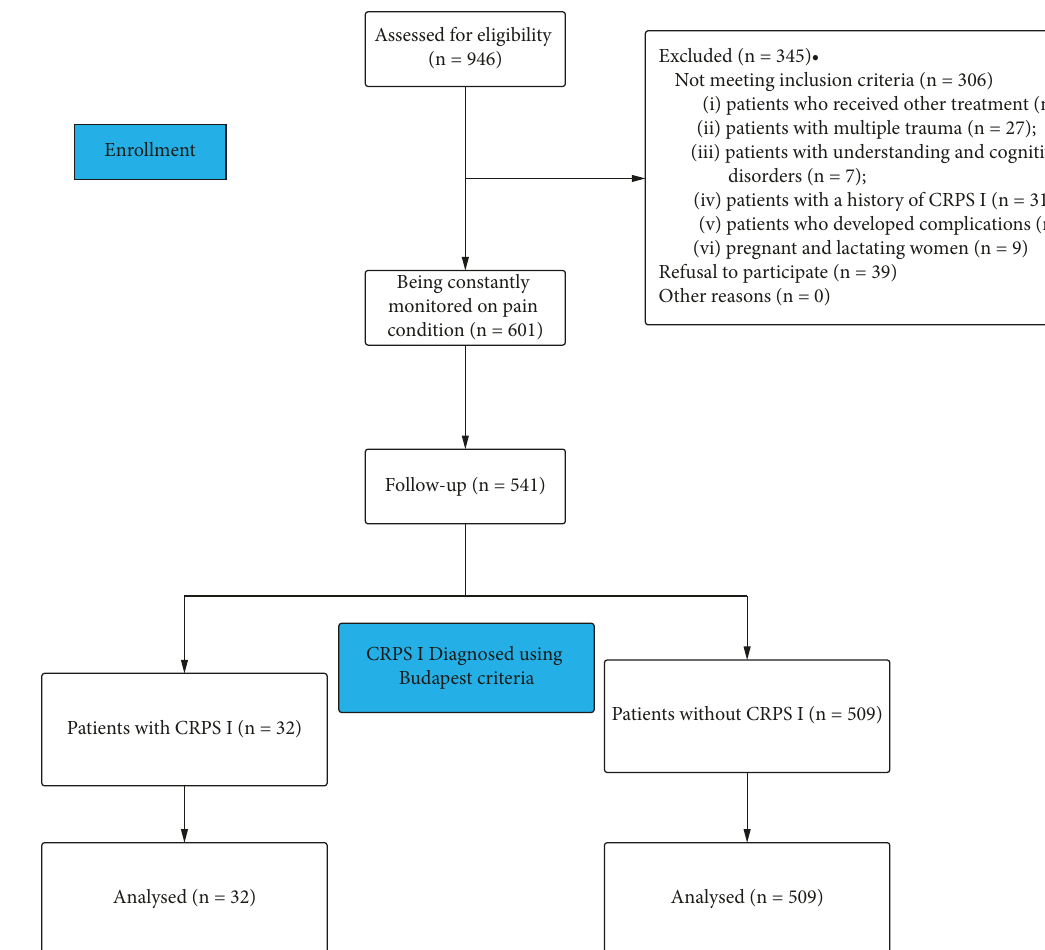
Figure 1: Flow chart of patients included in the present